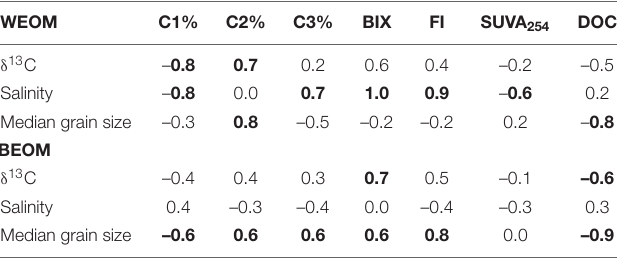
TABLE 3 | Pearson correlations between optical indicators and bulk characteristics of the WEOM and BEOM.